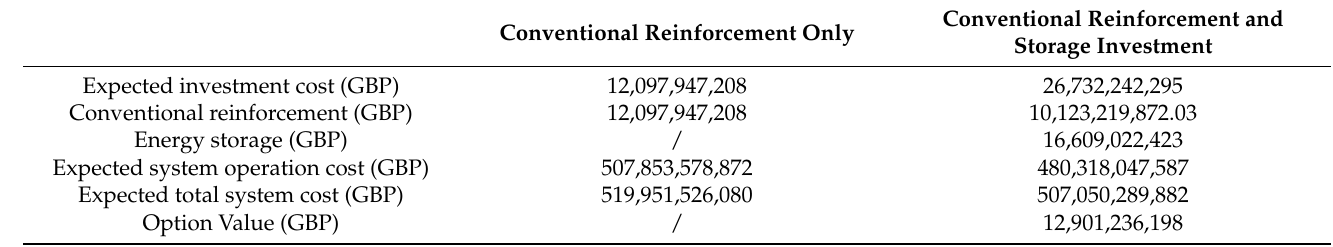
Table 1. Expected costs and Option Value of energy storage. Conventional Reinforcement Only